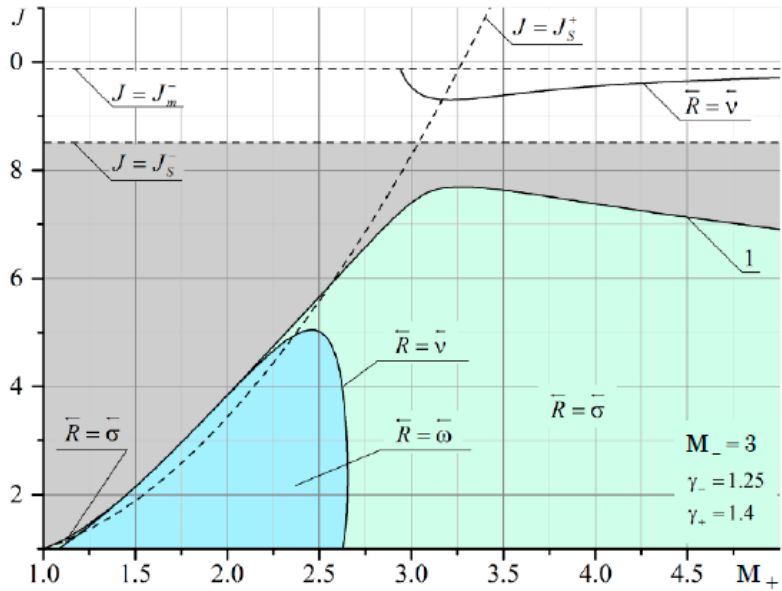
Figure A2. Domains of existence of reflected discontinuities for refraction from a gas consisting of combustion products into a diatomic gas. The Mach number of the flow from which the shock comes is M – = 3. The domains of existence of reflected discontinuities for refraction from a gas consist- ing of combustion products into a diatomic gas at the Mach number of the flow M – = 5 are shown in Figure A3.